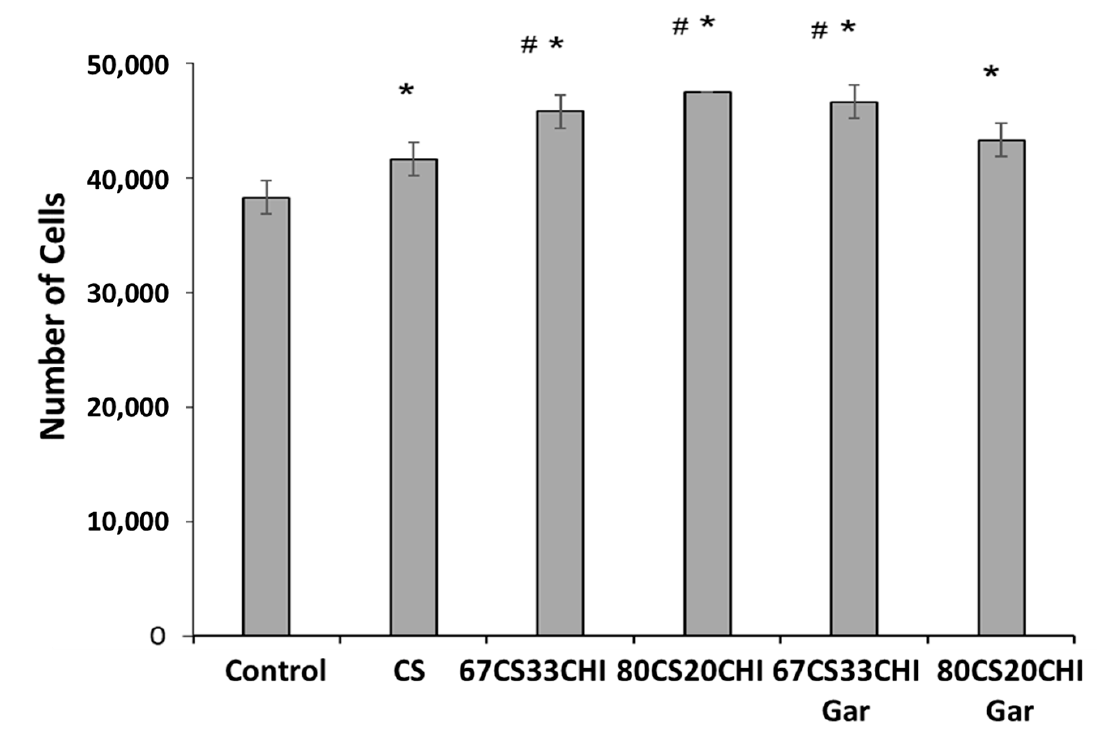
Figure 5. Response of fibroblast cells towards the different compositions of the hydrogels- * symbolizes the significant difference between control and other groups as p value is ≤ 0.05, # symbolizes the significant difference ( p ≤ 0.05) between the CS and 67CS33CHI, 80CS20CHI and 67CS33CHI-Gar.